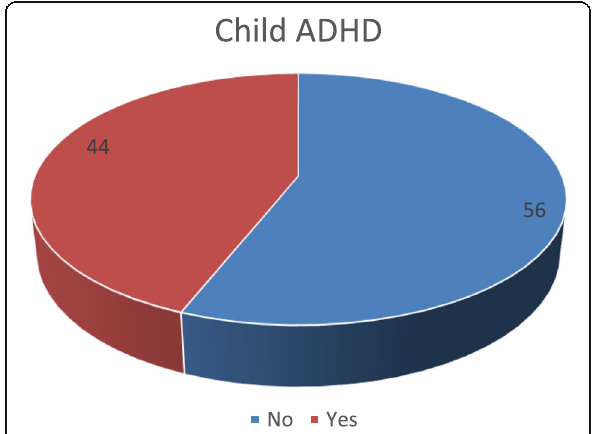
Fig. 1 Pie chart showing frequency distribution of childhood ADHD symptoms among the studied